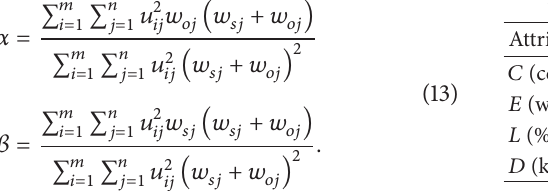
Table 6: Measurement value of attribute and parameter setting for utility